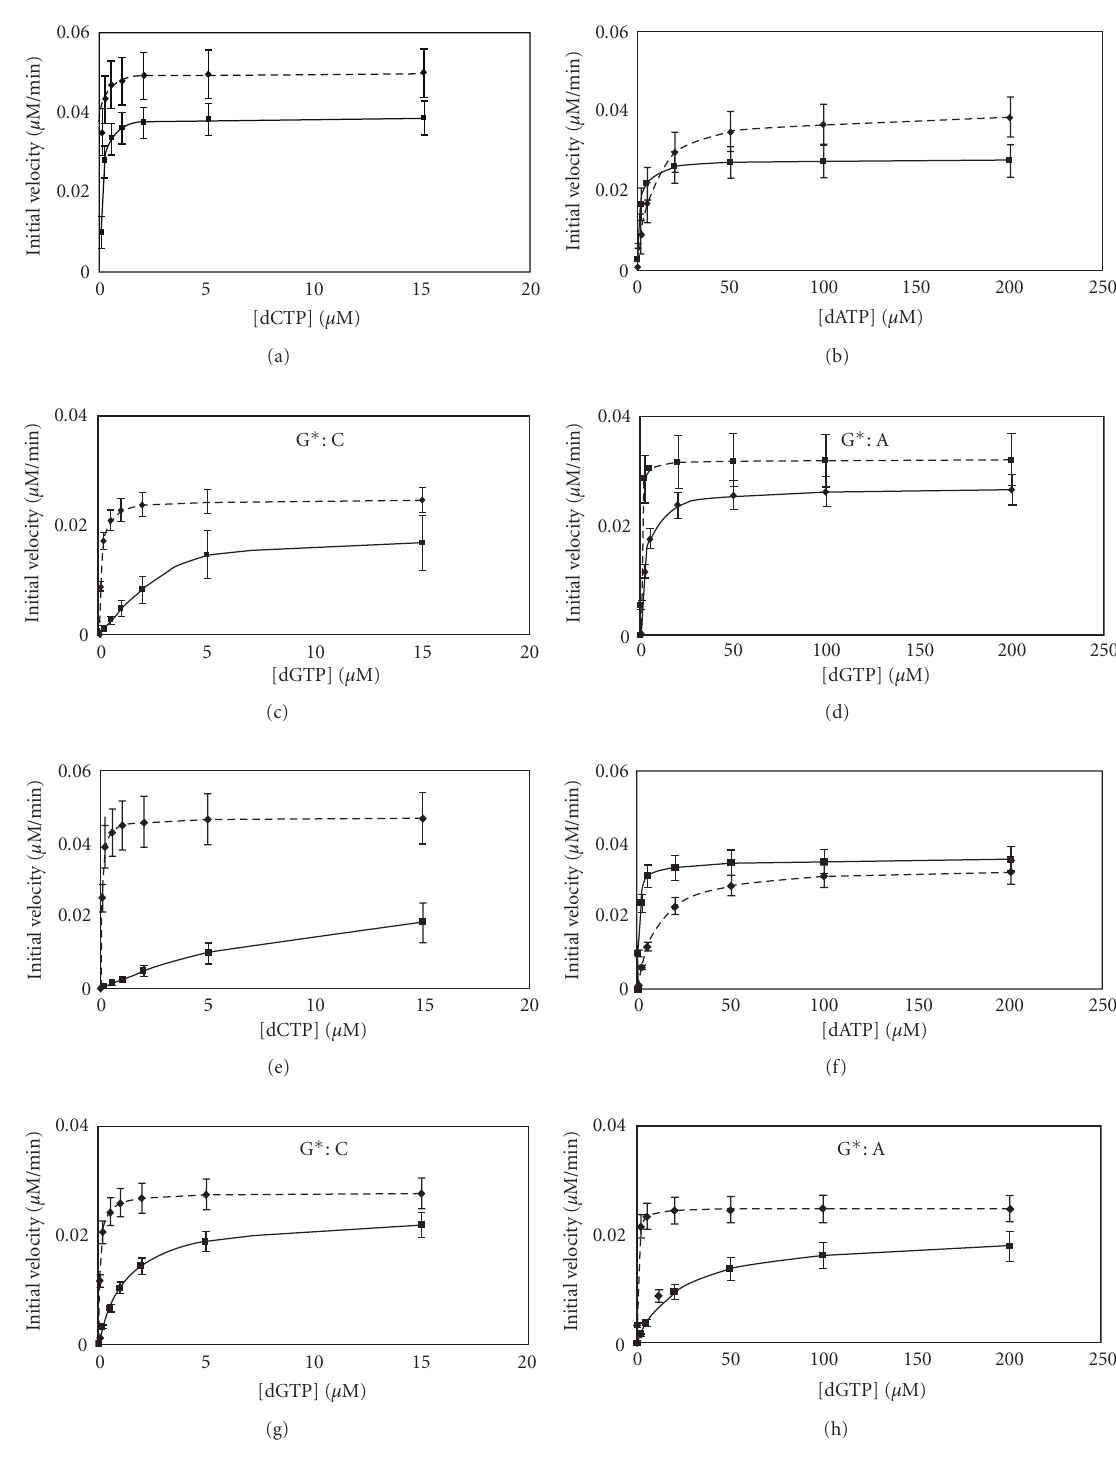
Figure 4: Single nucleotide incorporation and extension assay. Template-primer (50nM) was incubated with 6.4nM hPol η or yPol η for various times with increasing concentrations of dNTP. Steady-state kinetics for single nucleotide incorporation opposite cross-linked (G) (solid line) or control (G) (dashed line) are shown in (a), (b), (e), and (f). (a) and (b) represent dCTP and dATP incorporations, respectively, for hPol η whereas (e) and (f) represent the same for yPol η . Steady-state kinetics for dGTP incorporation opposite (C) immediately following the cross-linked (G) (solid line) or control (G) (dashed line) are shown in (c), (d), (g), and (h). (c) and (d) represent extension of G ∗ :C and G ∗ :A pairs, respectively, for hPol η whereas (g) and (h) represent the same for yPol η . Error bars show the standard deviation of at least three